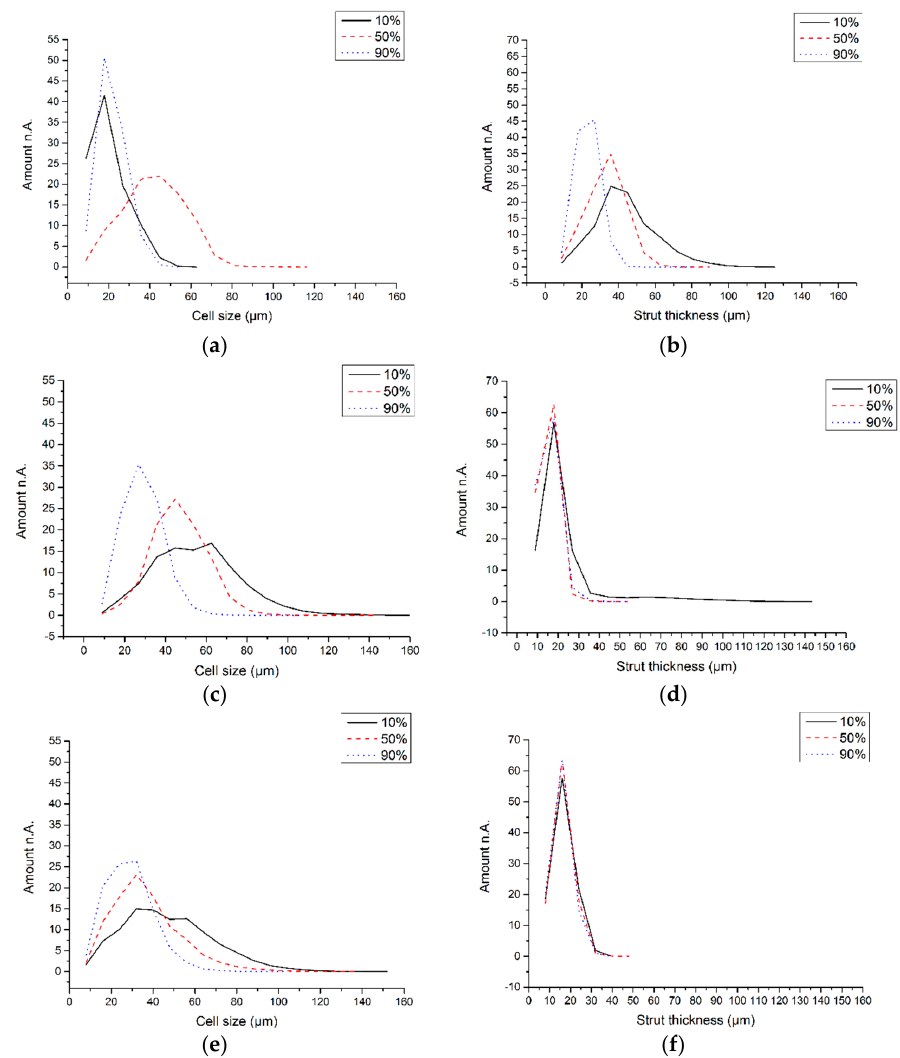
Figure 7. Calculated dimensions at different depths, h, in monoliths prepared at various slurry concentrations, φ v . ( a ) φ v = 0.128 Cell size; ( b ) φ v = 0.128 Strut size; ( c ) φ v = 0.064 Cell size; ( d ) φ v = 0.064 Strut size; ( e ) φ v = 0.032 Cell size; ( f ) φ v = 0.032 Strut size.